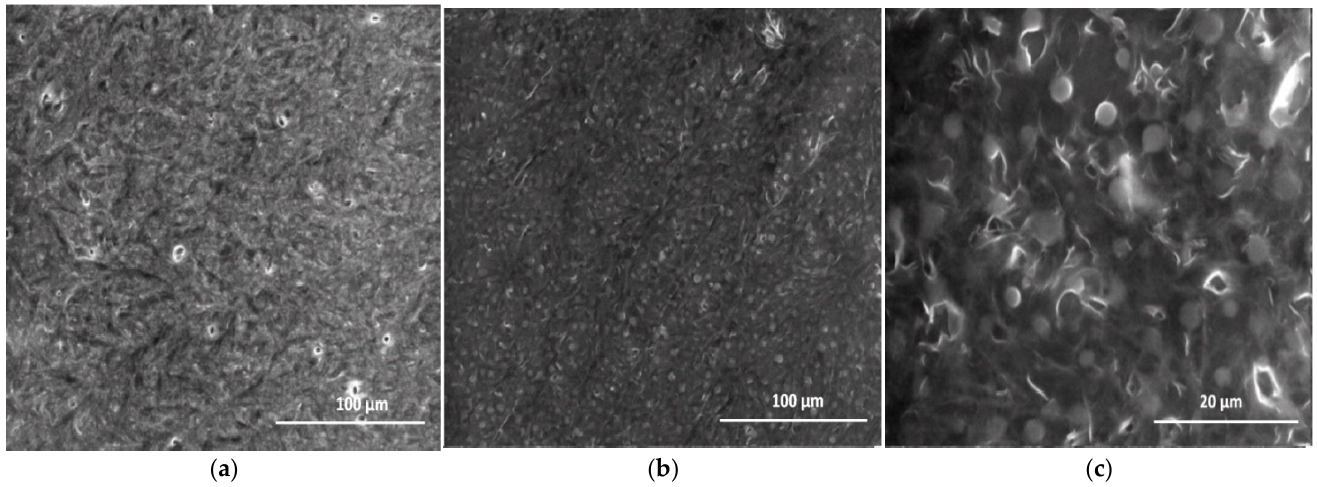
Figure 13. SEM micrograph for the microstructure of the PEBSA polymer matrix ( a ) and of PEBSA_Ty complex ( b , c ).